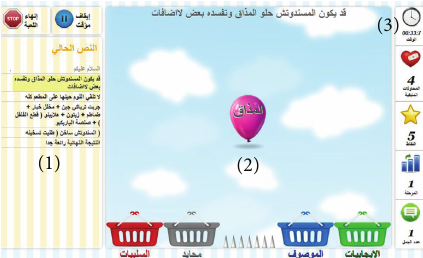
Figure 2: The interface of the game-based component. The interface consists of three panels. (1) The dashboard: it consists of control buttons that enable the user to pause the game or terminate it. It also consists of the review which is also the queue of the upcoming sentences in current game round. (2) The canvas panel: in it the words of the sentence will drop as balloons and the user saves the balloons from blowing up by dragging them to one of the four baskets. (3) The third panel is the statistics panel: it consists of basic statistics and information needed by the player to track his/her